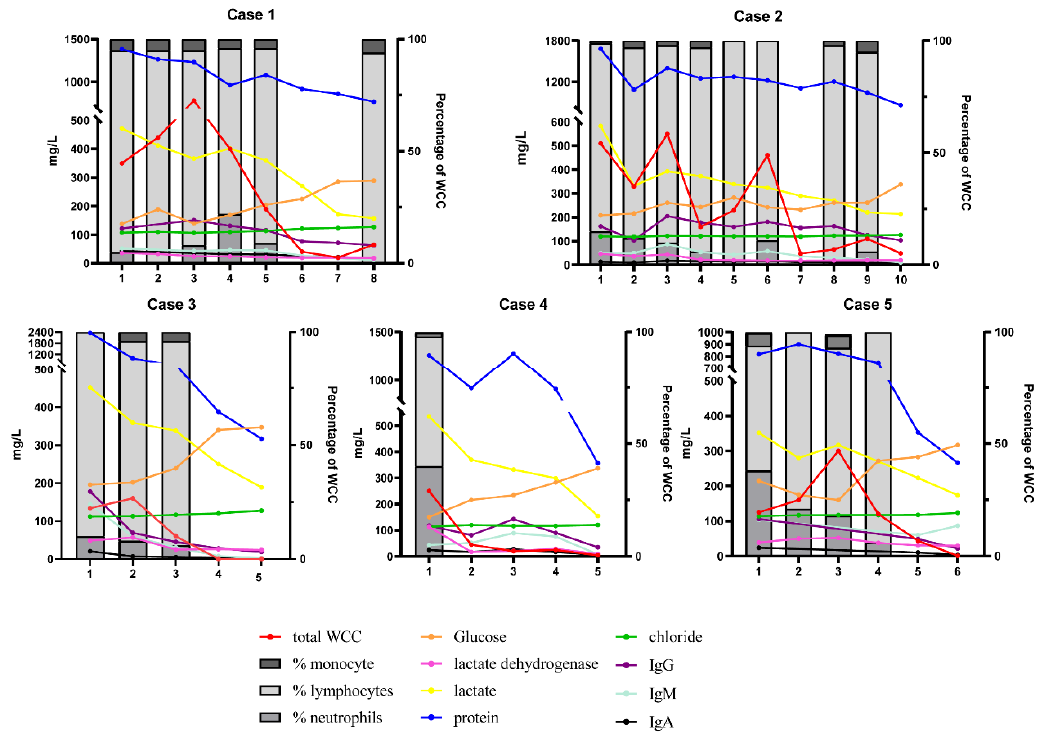
Figure 1. Dynamic changes in various CSF indices in five patients with TBM. The percentage of monocytes/lymphocytes/neutrophils (right Y axis); the total white cell count (WCC; 106/L), and the concentrations of glucose (mmol/L × 10 − 2 )/chloride (mmol/L)/protein (mg/L), lactate dehydrogenase(U/L), lactate (mmol/L × 10 − 2 ), and the concentrations of IgG//IgM//IgA in CSF (left Y axis); IgG//IgM//IgA (mg/L); Sequence of lumbar puncture (X axis); when the total number of leukocytes is less than 50 × 10 6 /L, the cells are not classified; see Supplementary Table S1 for details of lumbar puncture time and various index values.